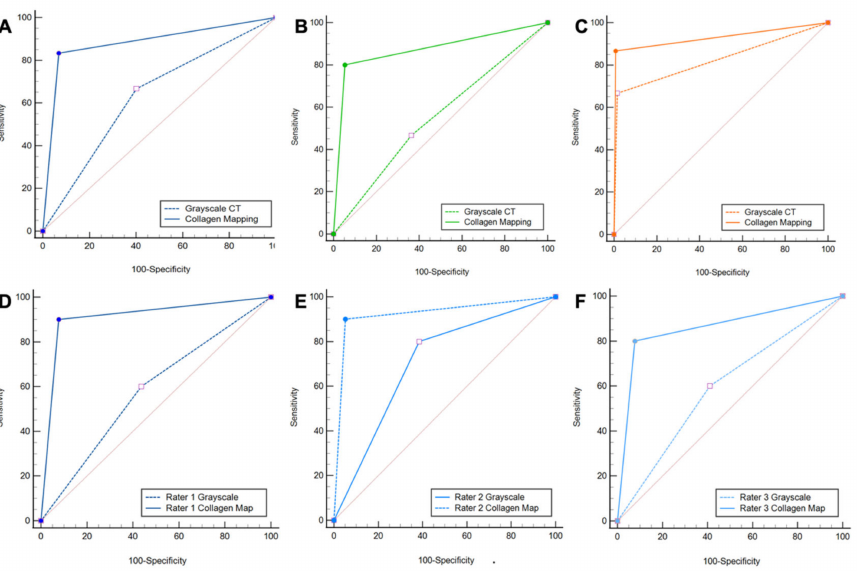
Figure 3. ROC curve analysis. ROC curve analysis shows increased diagnostic accuracy of protocol 2, which included color-coded collagen mappings and grayscale CT (solid line) over protocol 1, which included only standard grayscale CT (dotted line) for the depiction of DTFS injury ( A ) . Subgroup analysis confirmed the increased diagnostic accuracy for ligamentous tears ( B ), but not for avulsion fractures ( C ). All three readers improved significantly when color-coded collagen mapping was available ( D – F ). Abbreviations: ROC, receiver operating